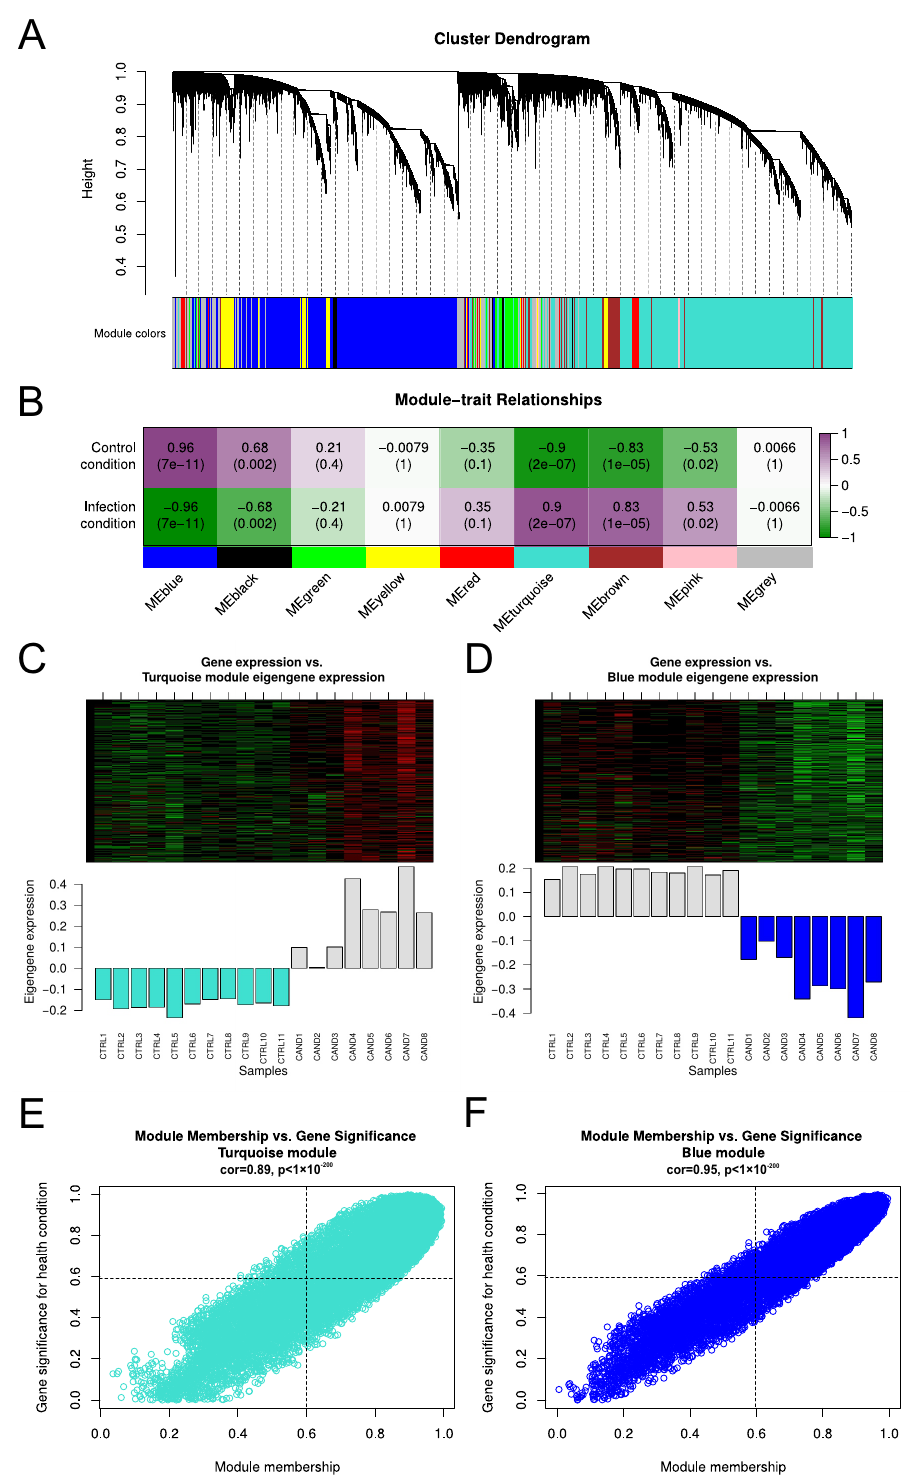
Figure 2. ( A ) Cluster dendrogram representation of the co-expression network modules. ( B ) Cor- relation between the eigengene modules and the health condition trait. ( C ) Heatmap presenting the sample gene expression for the turquoise module. The barplot shows the module eigengene expression value associated with each sample. ( D ) Heatmap presenting the sample gene expression for the blue module. The barplot shows the module eigengene expression value associated with each sample. ( E ) Correlation between gene significance (GS) and MM for genes in the turquoise module. ( F ) Correlation between gene significance (GS) and MM for genes in the blue